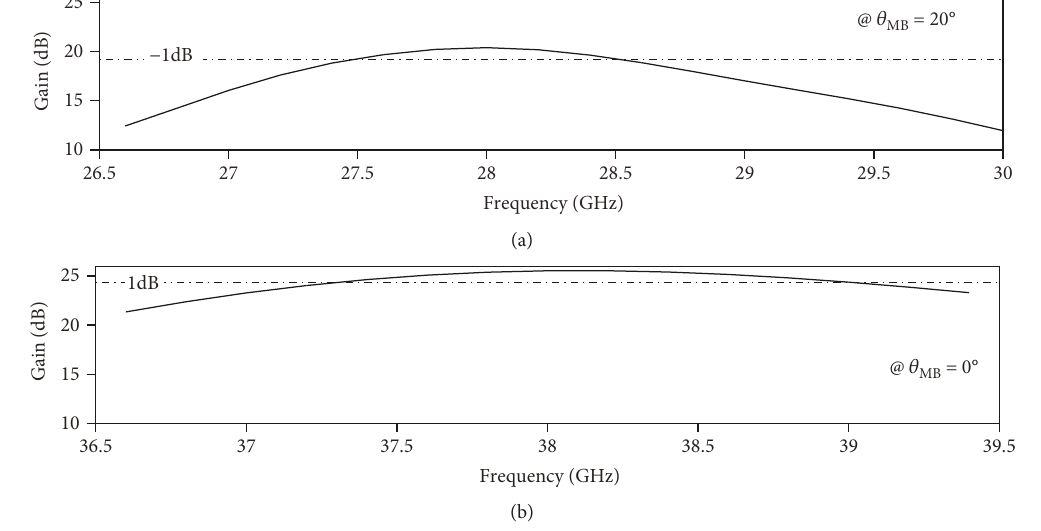
Array prototype